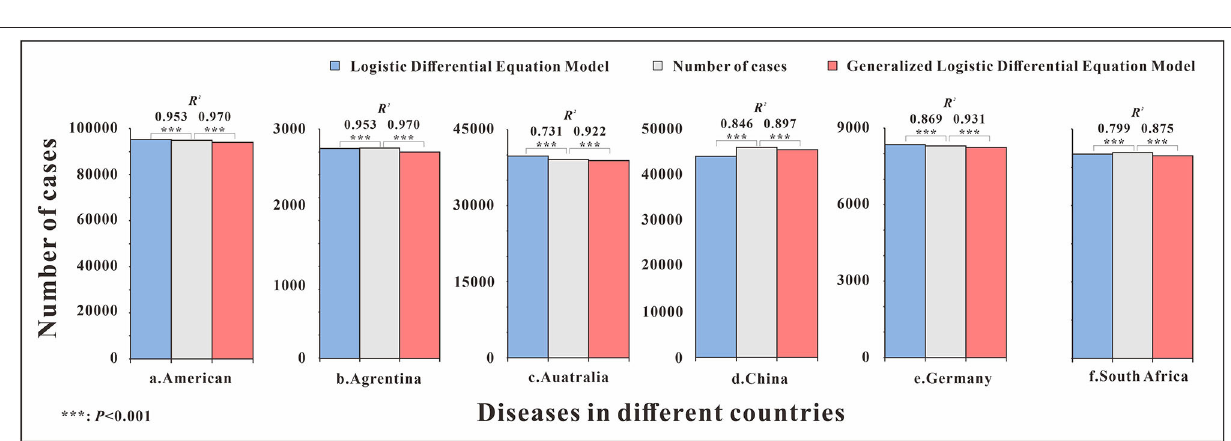
FIGURE 6 | Number of cumulative cases and R 2 of logistic and generalized logistic differential equation models in different areas. *** p <